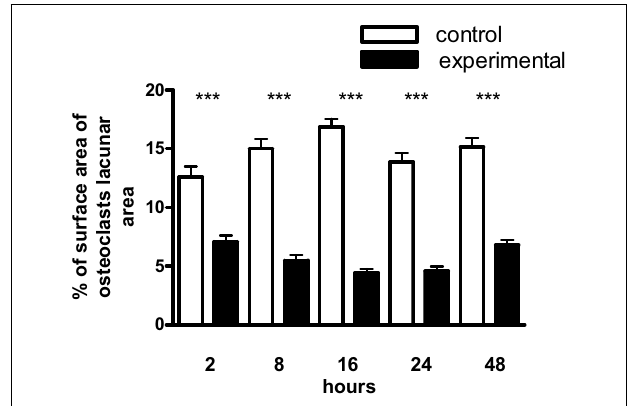
FIGURE 4 | Effect of conditioned media from osteoblast cultures on the surface area of mouse osteoclast resorption lacunae . Osteoclasts were obtained from the femurs of 2–3-day-old BALB/C mice and allowed to settle on ivory slices for 20min at 37°C.The substrate was washed free of non-adherent cells and the slices incubated for 24h in 500 µ L of conditioned medium plus 500 µ l fresh DMEM; resorption was quantified by measuring the surface area of the resorption lacunae by image analysis.The values represent the means ± SEM from four slices at each time point. ***Experimental significantly less than control. P <